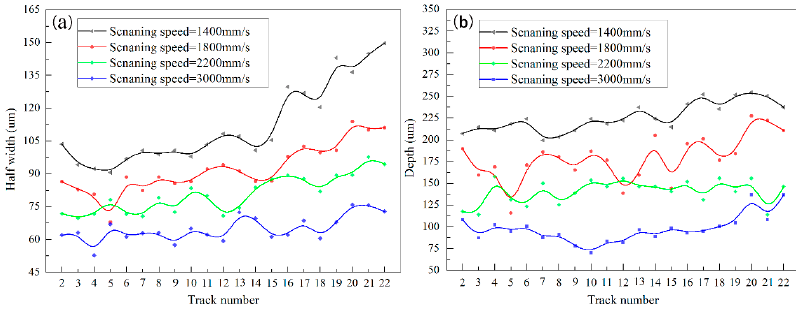
Figure 9. The half width ( a ) and depth ( b ) of molten pool of different tracks.